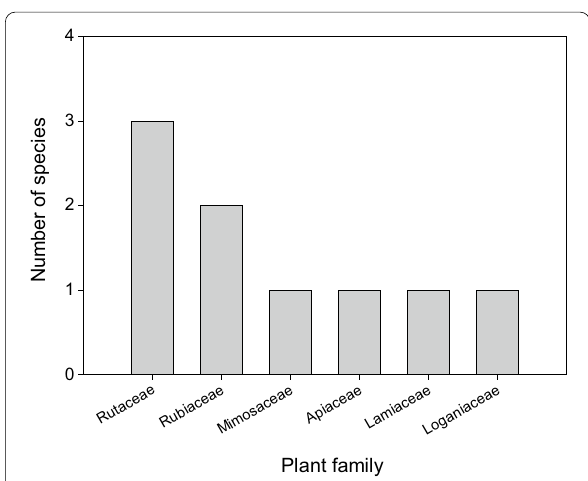
Fig. 2 Number of plant species per family used for managing TB symptoms in Kitgum and Pader districts, Uganda